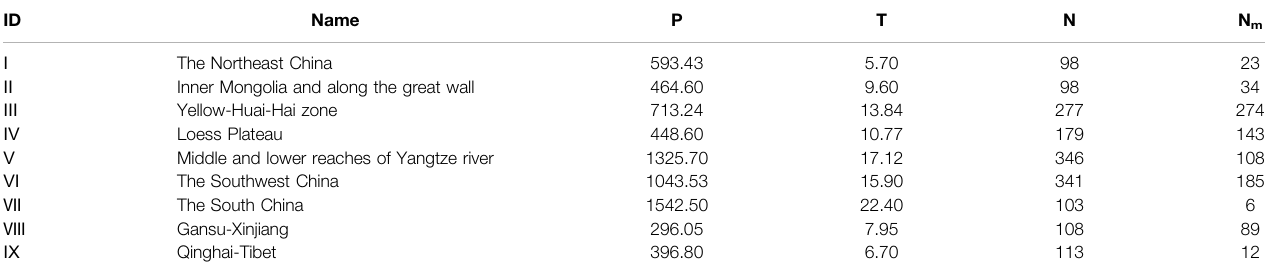
TABLE1| Averageannualprecipitation(P,mm/year)andaverageannualtemperature(T, ° C/year),thenumberofwheat-plantingcountiesandthenumberofmainproducing counties in the nine agricultural